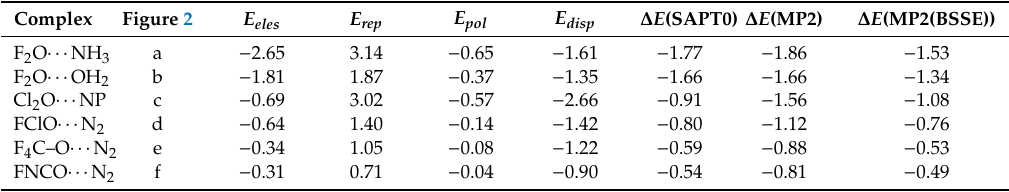
Table 2. Comparison of the DFT-SAPT decomposed energy components and the total SAPT0 interaction energies with the MP2 computed uncorrected and corrected binding energies for the six binary complexes a